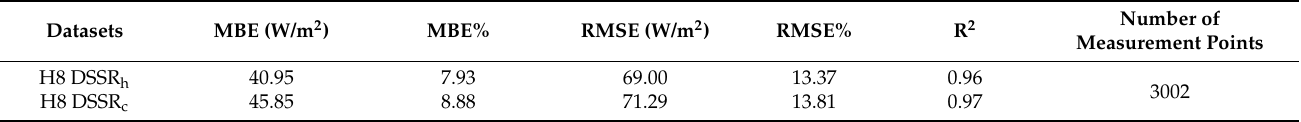
Table 3. Accuracy comparison between the downscaled and original H8 10-min products in the